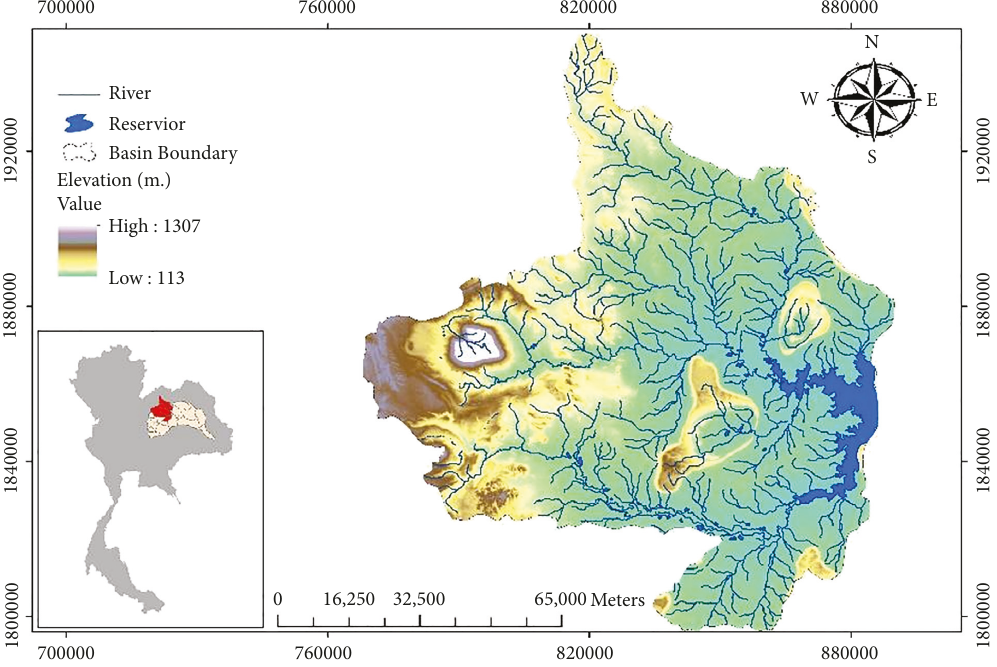
Figure 1: The location of Ubolratana reservoir.